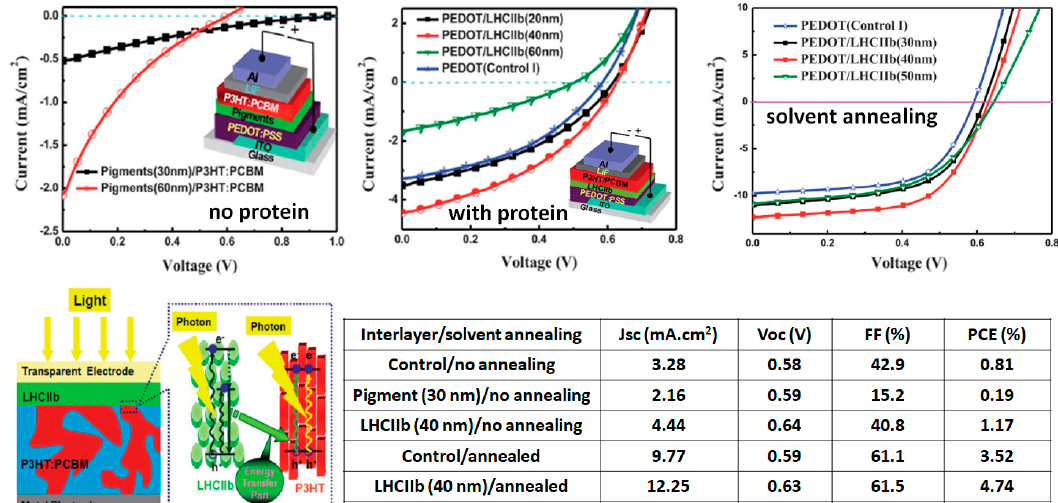
Figure 9. Comparative J – V characteristics of P3HT:PC 61 BM OSCs with pigments or LHCIIb as interlayer material. Schematic representation of the working principle and photovoltaic performances. Adapted with permission from Reference [54]. Copyright 2012 Royal Society of Chemistry.